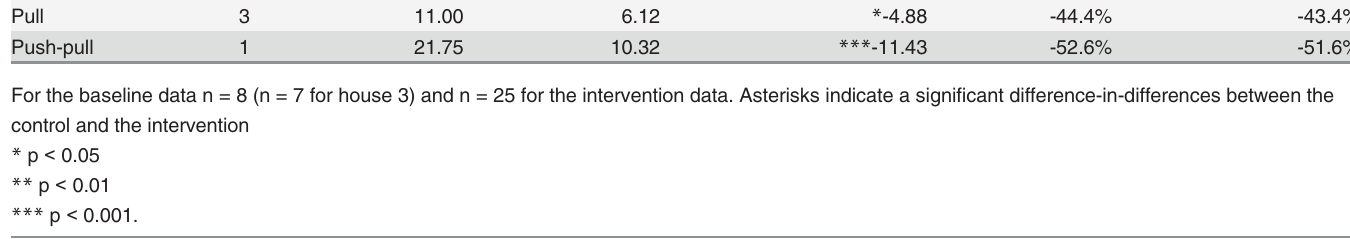
Table 2. Mean overall CDC trap mosquito catches for the different interventions. Intervention